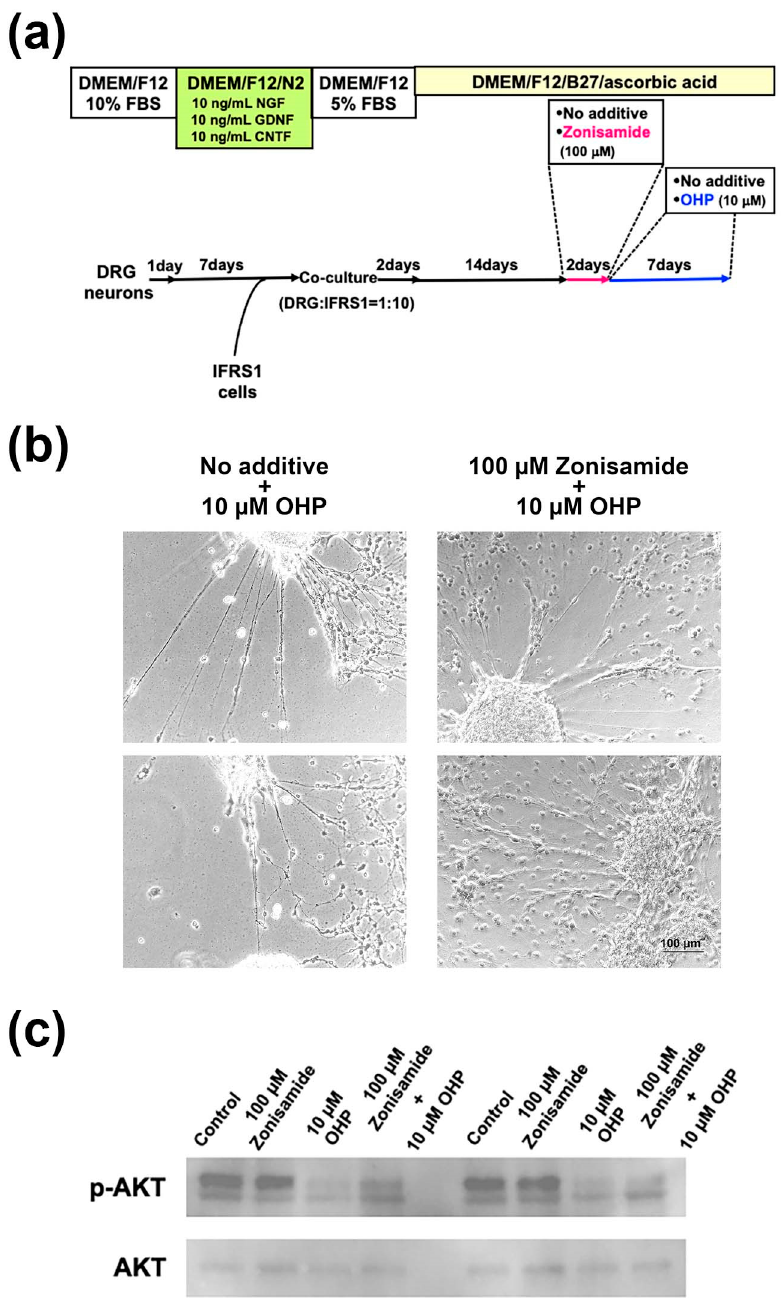
Figure 5. Zonisamide pretreatment alleviates the OHP-induced neurite degeneration as well as the demyelination-like changes in DRG neuron–IFRS1 co-cultures: ( a ) Schematic representation of the co-culture-generating procedure and the applications of zonisamide and OHP. ( b ) Representative phase-contrast micrographs of the co-cultures at 7 days after the OHP treatment in the presence (right) or absence (left) of a 2-day pretreatment with zonisamide. The pictures in the respective culture conditions were taken from the different co-cultures. ( c ) Preincubation with zonisamide (100 µ M) for 2 days attenuates the downregulated expression of phosphorylated AKT (p-AKT) in co-cultured cells exposed to OHP (10 μ M) for 7 days; results refer to Western blotting.